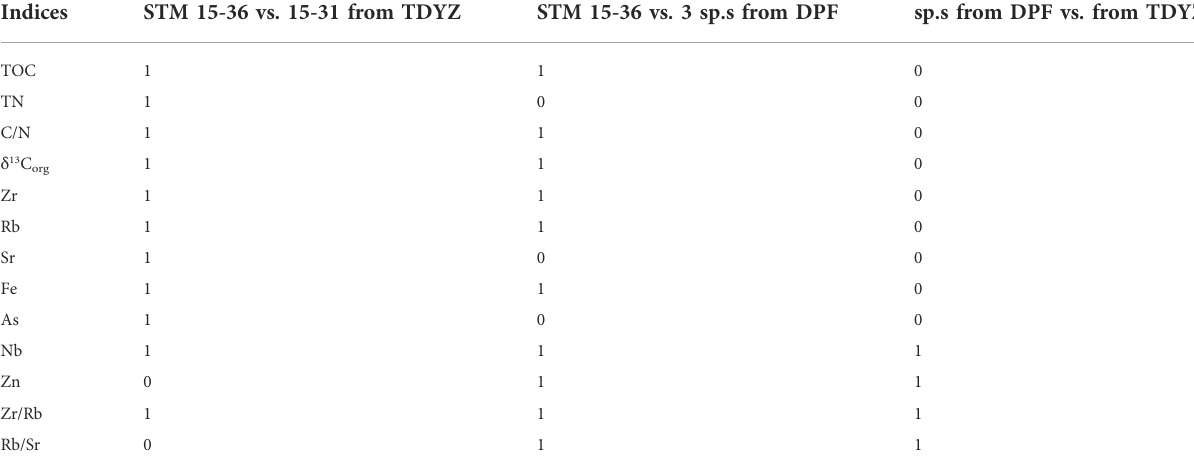
TABLE 3 Kruskal-Wallis analyses of the host sediment indicators between various specimens. Indices STM 15-36 vs. 15-31 from TDYZ STM 15-36 vs. 3 sp.s from DPF sp.s from DPF vs. from